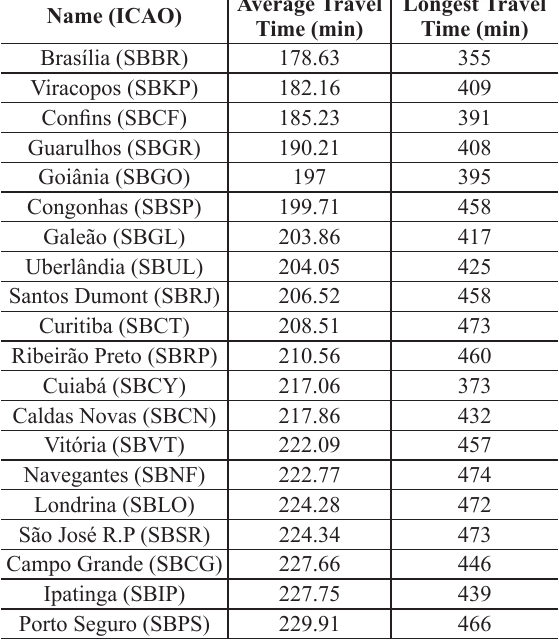
Top-20 smallest average time of all paths in the air transportation